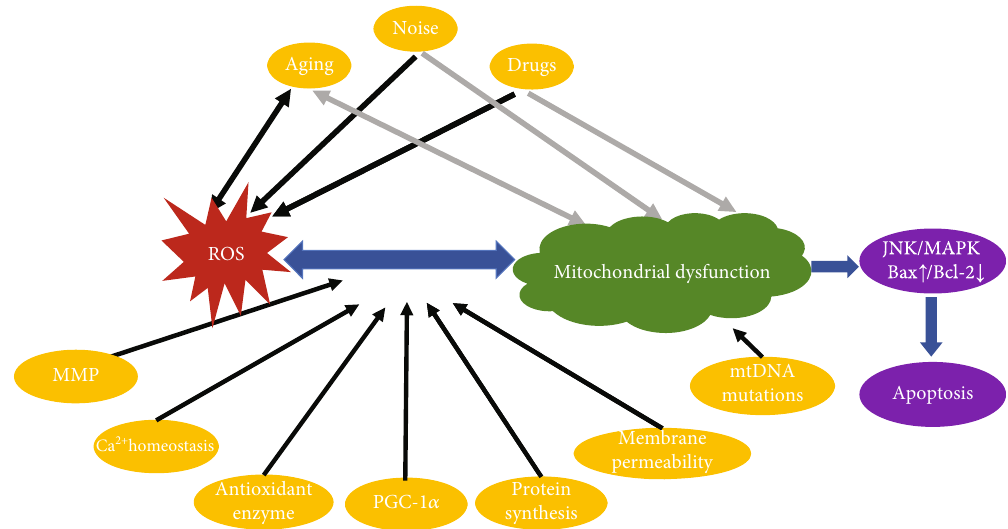
Figure 1: Stimulations induce ROS and mitochondrial dysfunction and fi nally cells ’ apoptosis. Diagram showing aging, noise, and drugs could induce ROS and the probable mechanism to lead to mitochondrial dysfunction, moreover, the interaction between ROS and mitochondrial dysfunction.